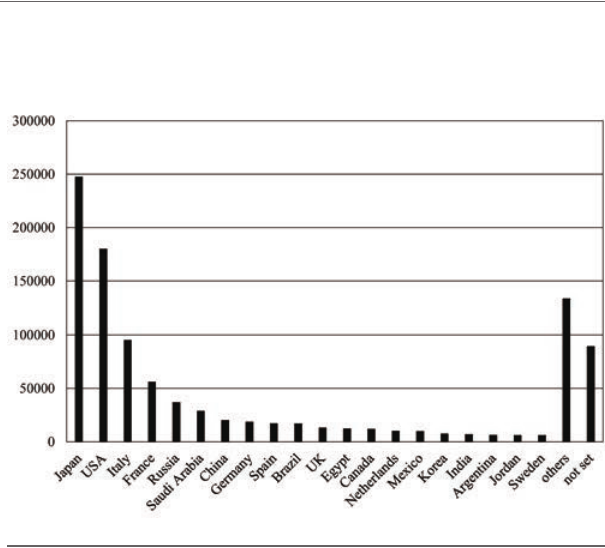
Figure 3. Number of visitors from each country. The top 20 coun- tries in terms of the number of visitors to our site are shown. Japanese visitors accounted for 24% of the visitors to our site, fol- lowed by visitors from the USA (17.5%), Italy (9.2%), France (5.4%), Russia (3.6%), and Saudi Arabia (2.8%). However, 12.9% of the site’s visitors did not indicate their country of